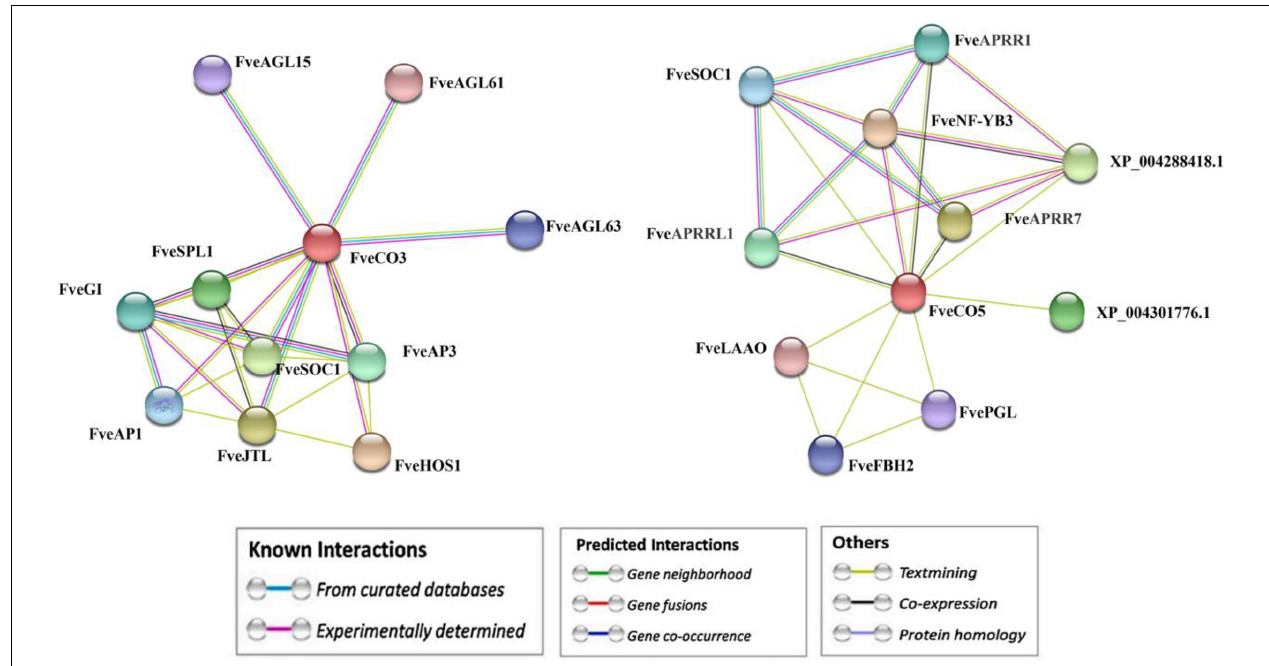
FIGURE 11 | Interaction network prediction of FveCO3 and FveCO5 with other proteins. The Fragaria vesca constans-like genes ( FveCOs ) are marked in